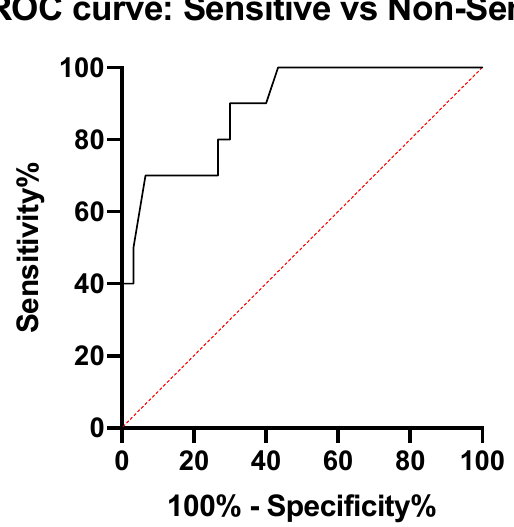
Figure 5. Receiver operating characteristics curve comparing ASA-sensitive patients ( n = 30) to ASA non-sensitive patients (AUC = 0.89, 95%CI 0.78–0.99, p =